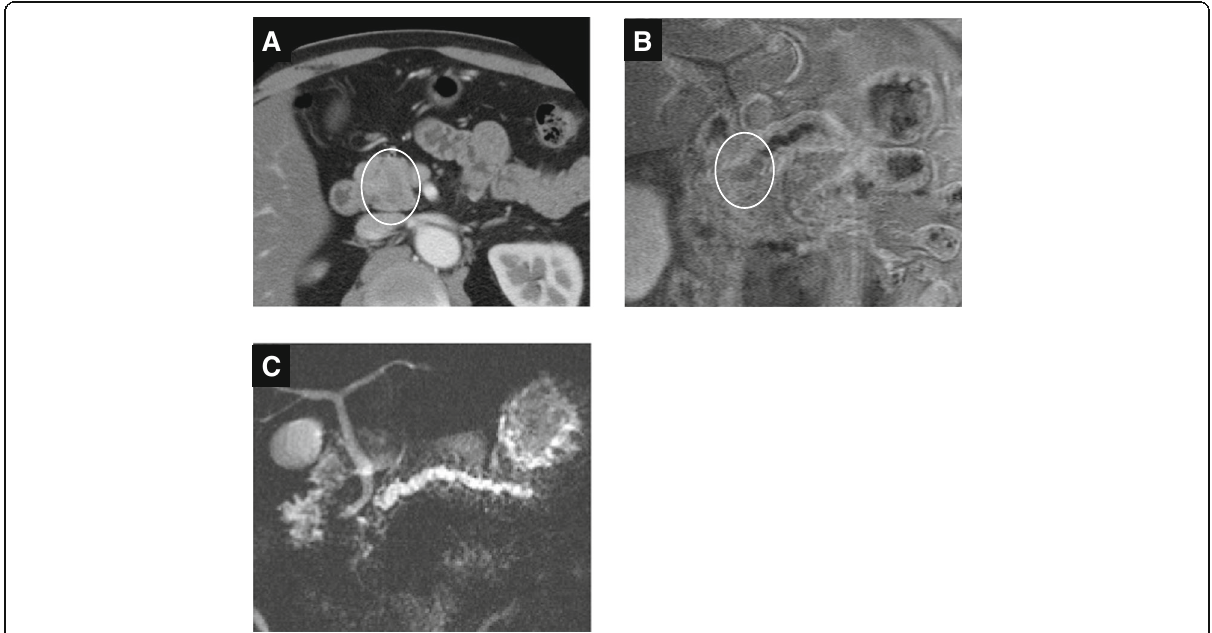
Fig. 1 Preoperative imaging findings during the assessment of the initial resected pancreas head lesion. a Enhanced computed tomography showed a dilated main pancreatic duct (MPD) with an enhancing mass (20 mm in diameter) at the head of the pancreas (circle). b , c Magnetic resonance cholangiopancreatography showed a low-intensity area in the pancreas head (circle) and dilation of the distal side of the MPD (5 mm in